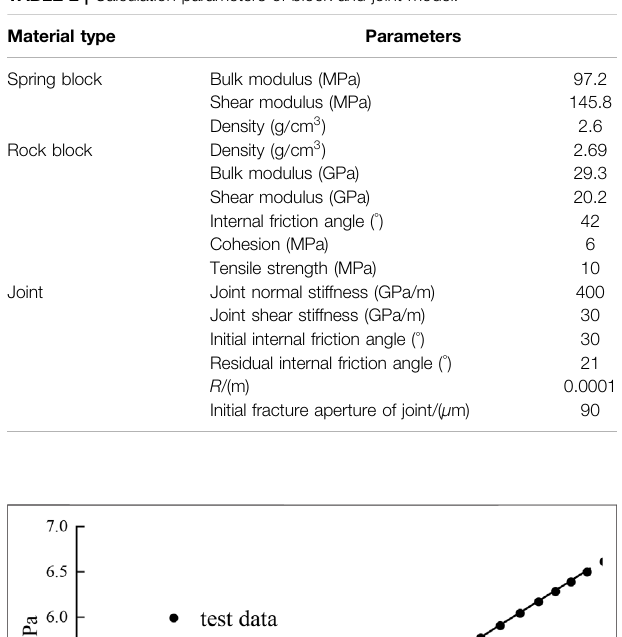
TABLE 2 | Calculation parameters of block and joint model.